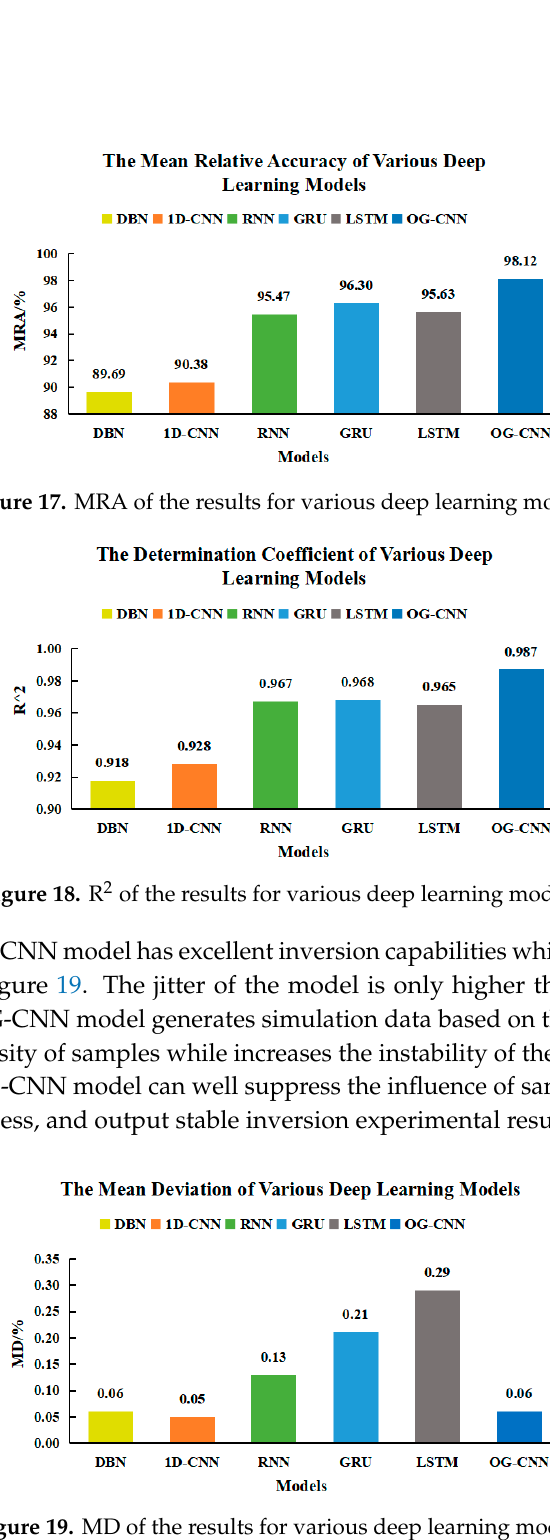
Figure 19. MD of the results for various deep learning models.